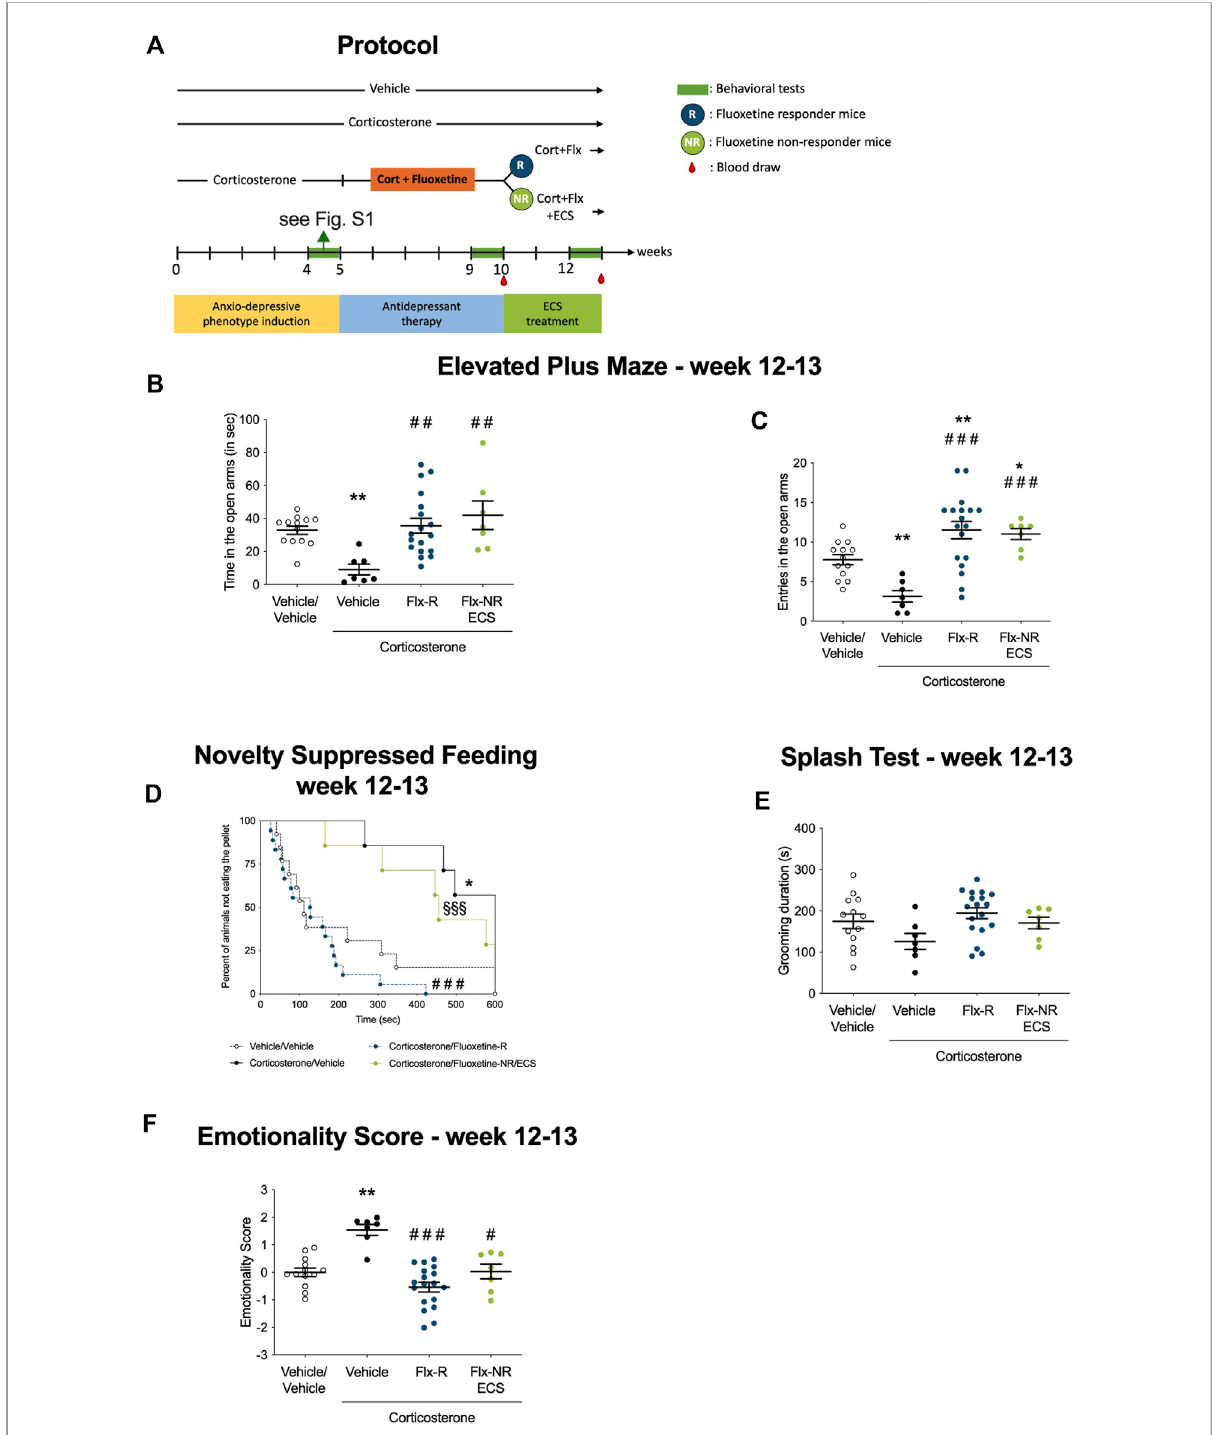
FIGURE 2 Fluoxetinenon-respondingmiceemotionalbehaviorwasrescuedafterchronicelectroconvulsiveseizures(ECSadministration). (A) Timelineof experiments:FollowingprotocolpresentedinFigure1A,Respondersandnon-respondersanimalswereselectedandPeripheralBloodMononuclear Cells were isolated from whole blood after W10. Chronic ECS treatment was applied in NR-mice while R underwent sham treatment. Emotional behavior was tested at W12 after ECS administration and PBMC extracted from whole blood. (B – C) Effects of chronic ECS on anxiety behaviors intheElevatedPlusMaze(EPM)inFlx-NRmice.Anxiety,measuredforvariousparametersisexpressedasmeantotaltimeinseconds (B) orentries (C) inopenarmsofEPMparadigm. (D) EffectsofchronicECSonanxiety-anddepressionrelatedbehaviorsintheNoveltySuppressedFeeding paradigm